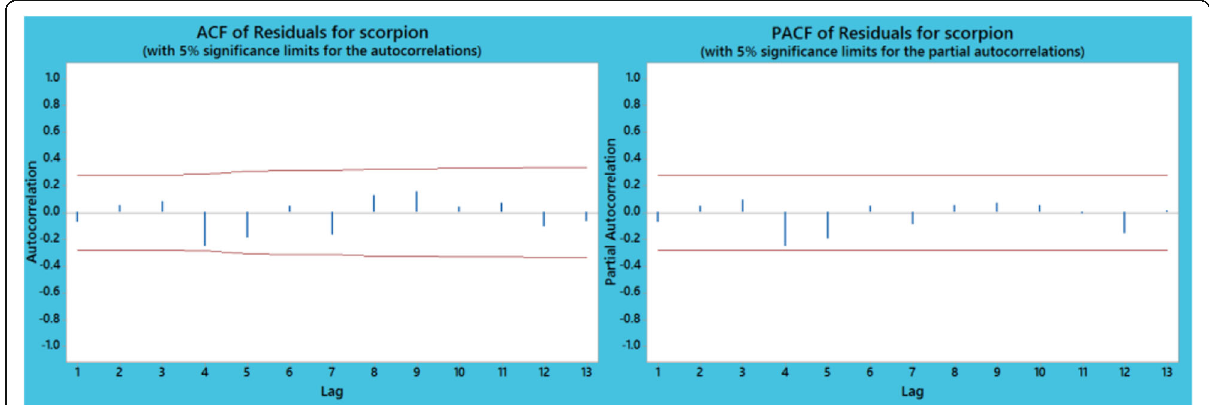
Fig. 8 Plot of autocorrelation (ACF) and partial autocorrelation (PACF) of residuals for scorpion sting data